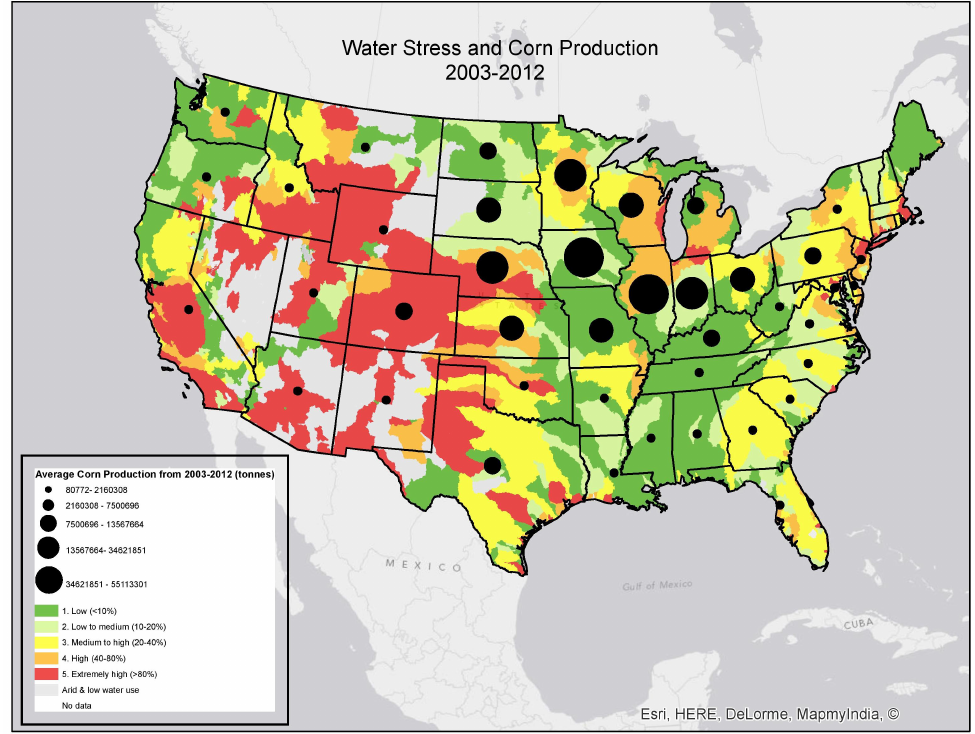
Figure 3. Water Stress and Corn Production Source: U.S. Geological Survey National Water Information System, https://waterdata.usgs.gov/nwis [9].